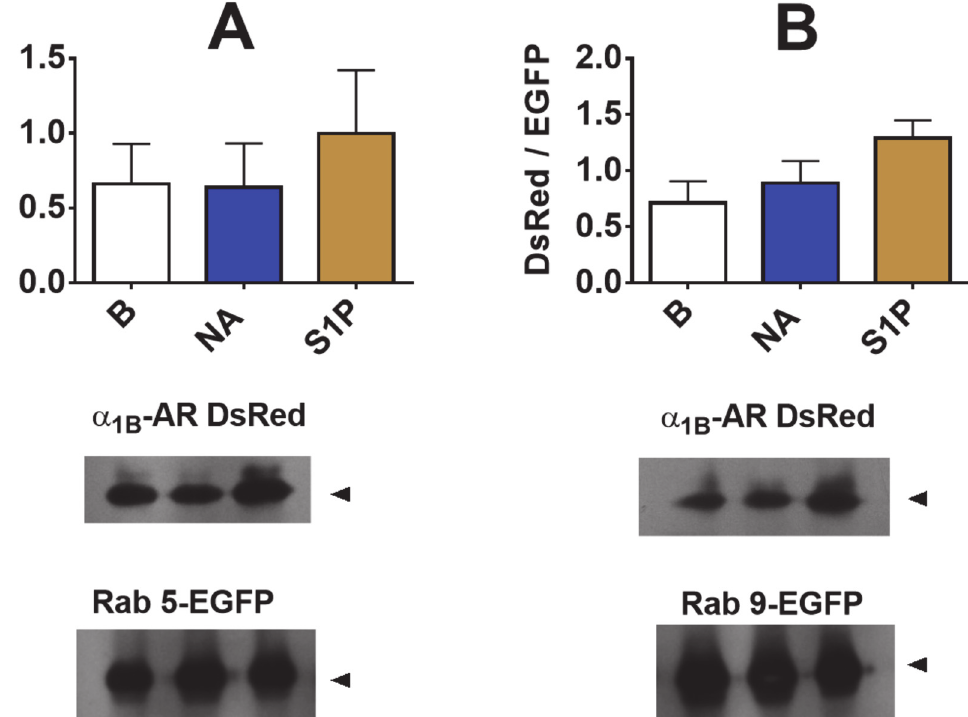
Fig 13. Coinmunoprecipitation of α 1B -adrenergic receptors and the marker proteins. Rab 5 (panel A) and Rab 9 (panel B) were studied. Cells were incubated for 15 min in the absence of any agent or presence of 10 μ M noradrenaline plus 1 μ M propranolol (NA) or 1 μ M sphingosine 1-phosphate (S1P). Cell lysates were obtained and the proteins were inmmunoprecipitated using an anti-EGFP antibody. The resulting immunocomplexes were analyzed by Western blots. The signal ratio (DsRed / EGFP) is plotted in the upper part of the panels; plotted are the means with vertical lines representing the S.E.M. of 3 experiments performed using different cell preparations. Representative blots are presented.